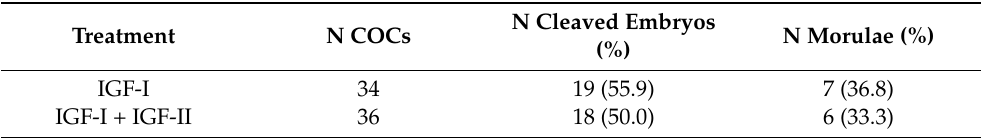
Table 3. Experiment C (Berlin): Effects of the addition of 20 ng/mL of IGF-I vs. the supplementation with 20 ng/mL of each of IGF-I and IGF-II on single IVM and culture embryo development after IVF. Treatment N